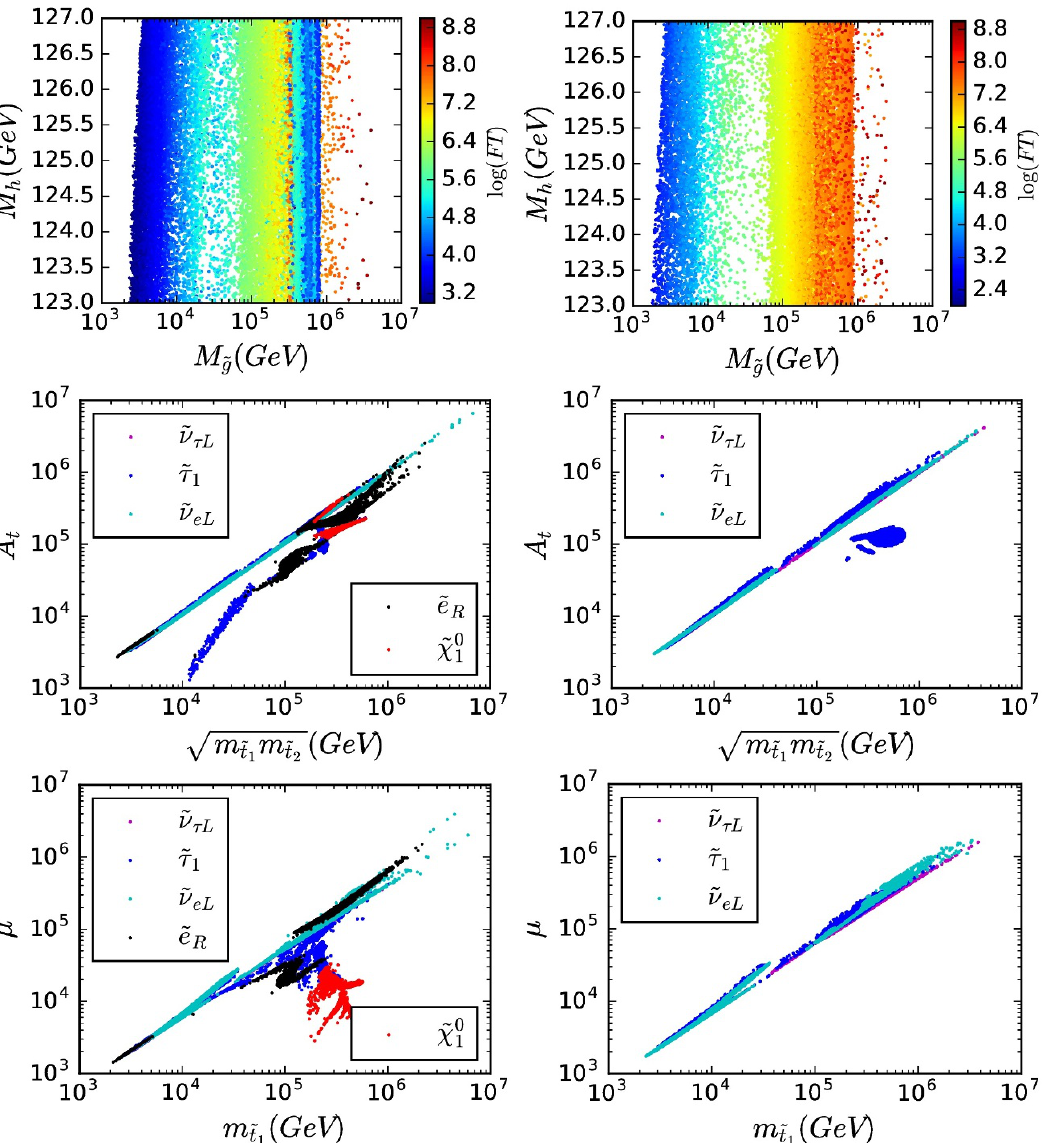
Figure 2 . Allowed regions for various LOSP with a = 3 (left panel) and a = 2 (right panel) in scenario I. All points satisfy the constraints from (I) to (III). In the upper panels, the BGFT measure is used to parameterize the level of